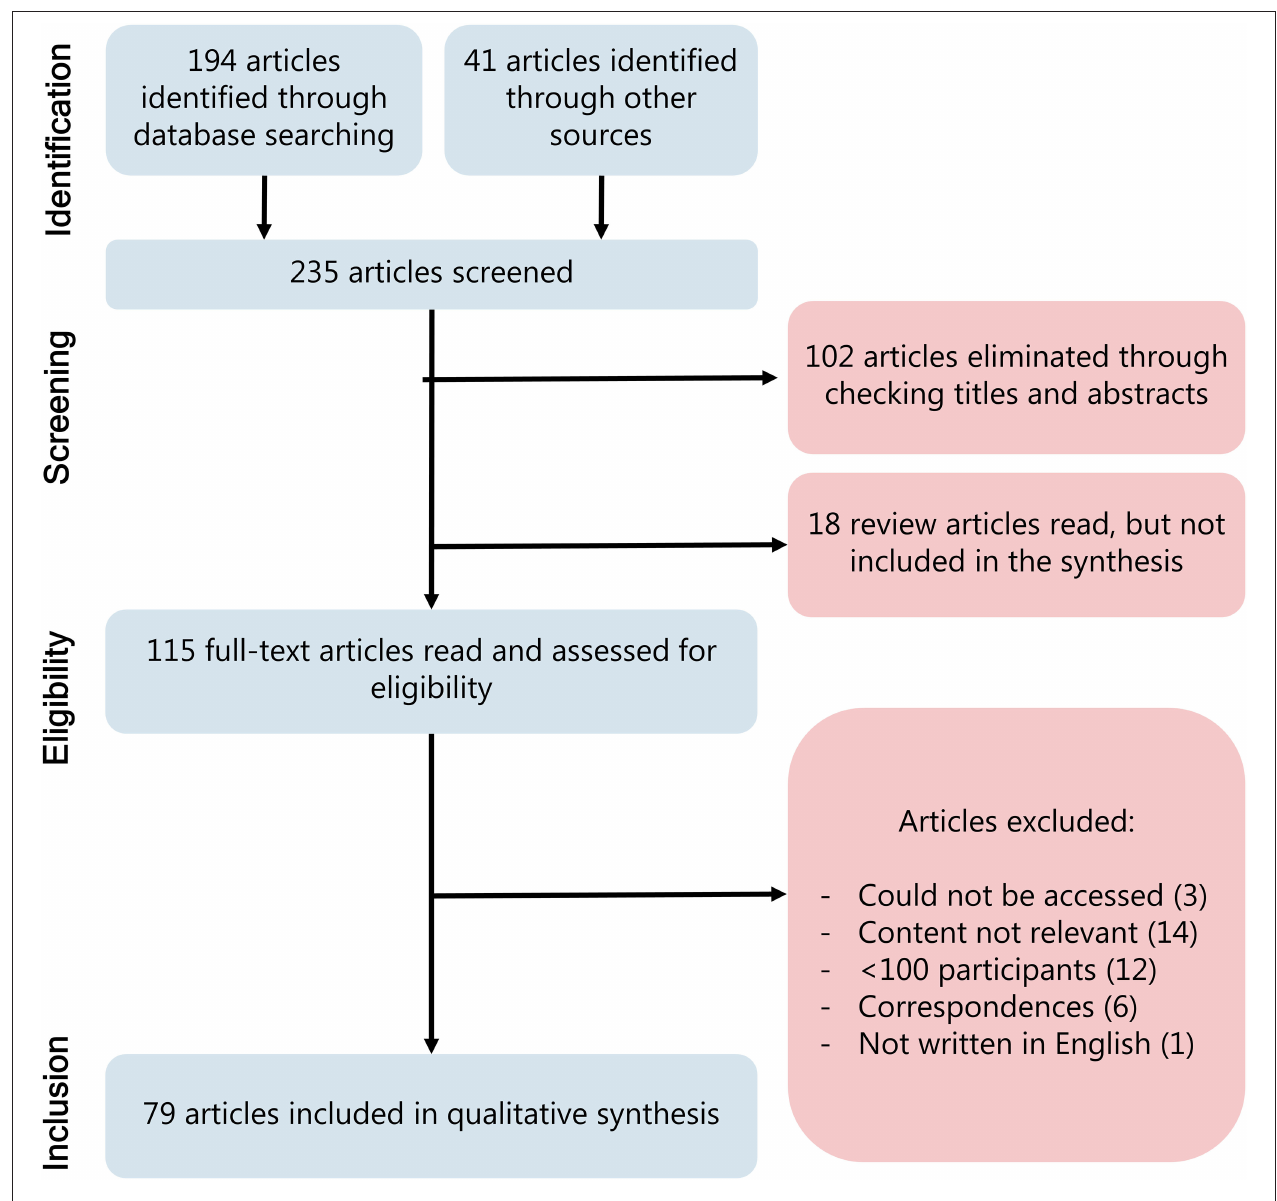
FIGURE 1 | PRISMA flow diagram for study